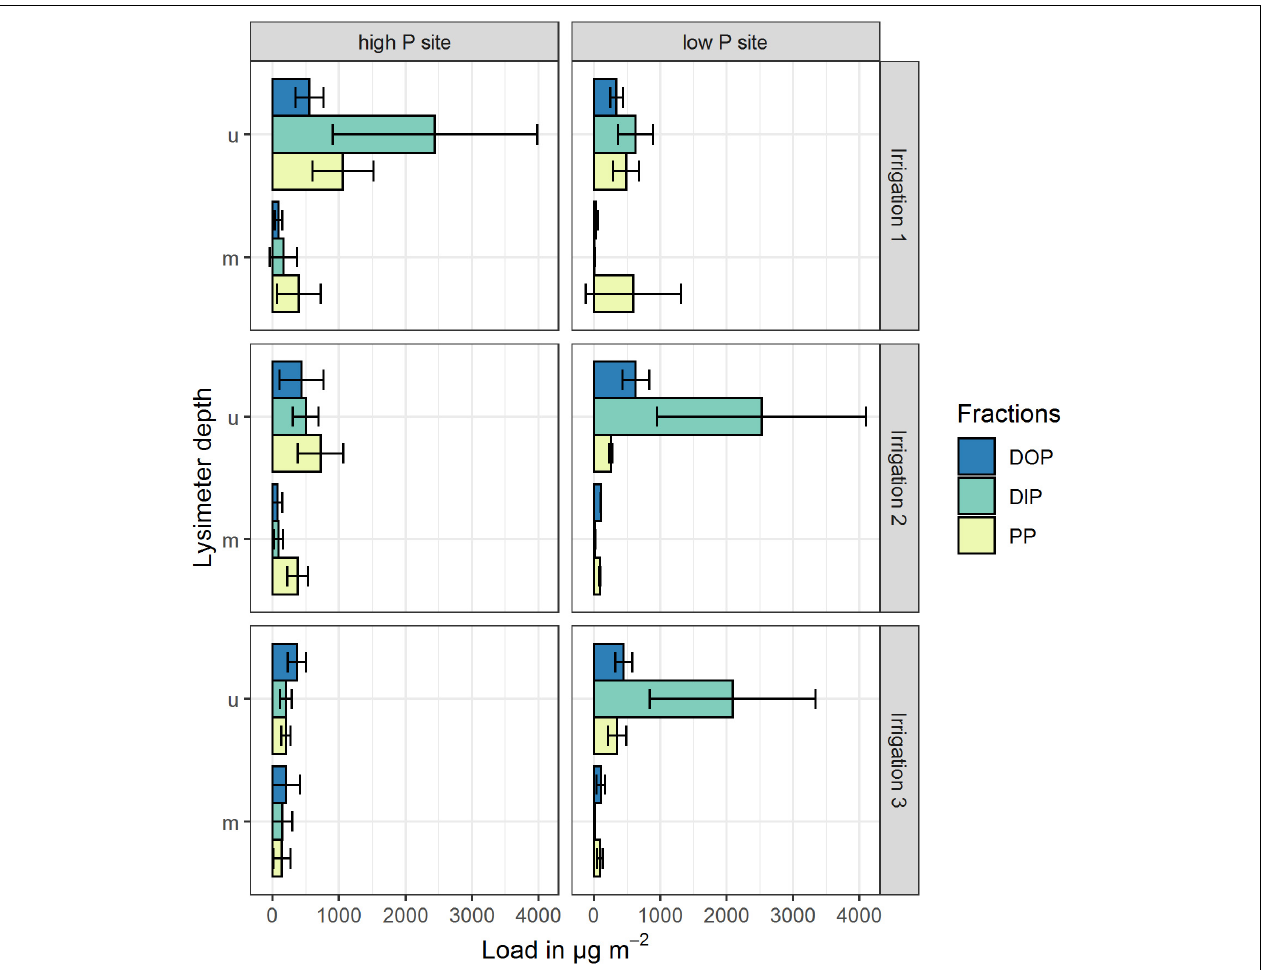
FIGURE 4 | Mean cumulative P loads in preferential flow water collected with zero-tension lysimeters during three irrigations at a high P and a low P site. Shown P fractions are DOP (dissolved organic P), DIP (dissolved inorganic P) and PP (particle bound P). Upper (u) and middle (m) lysimeter data are pictured, lower lysimeter data is not pictured. Values represent arithmetic means of three replicates, cumulated over the experimental period (4 h irrigation + 3 h after irrigation sampling). Error bars represent the standard deviation of the